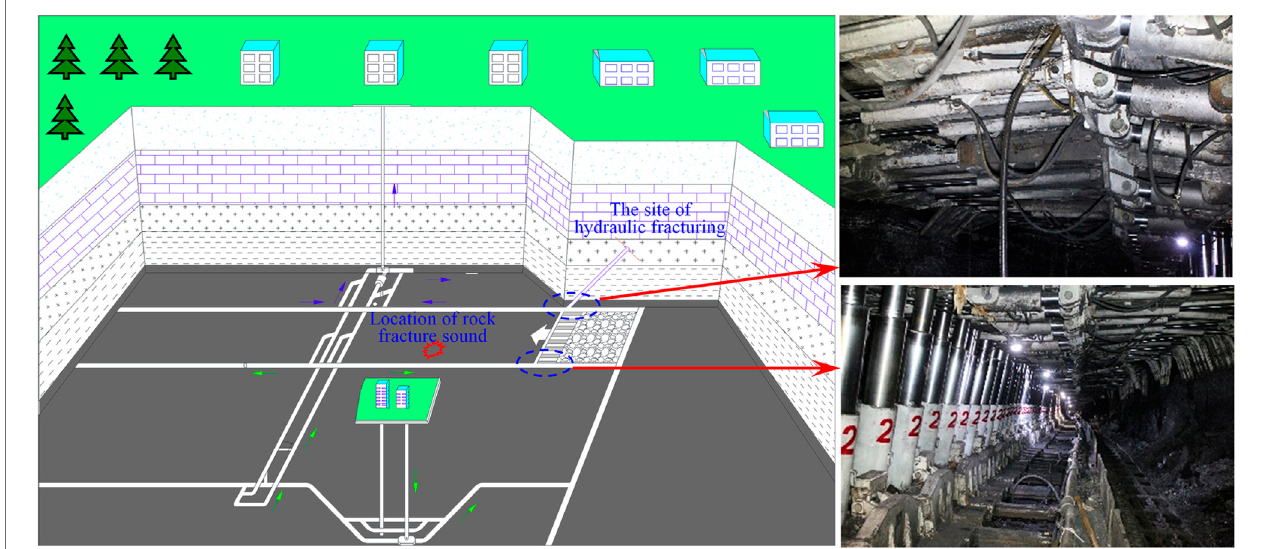
FIGURE 1 | Position of “ coal cannon ” during hydraulic fracturing in underground coal mines.